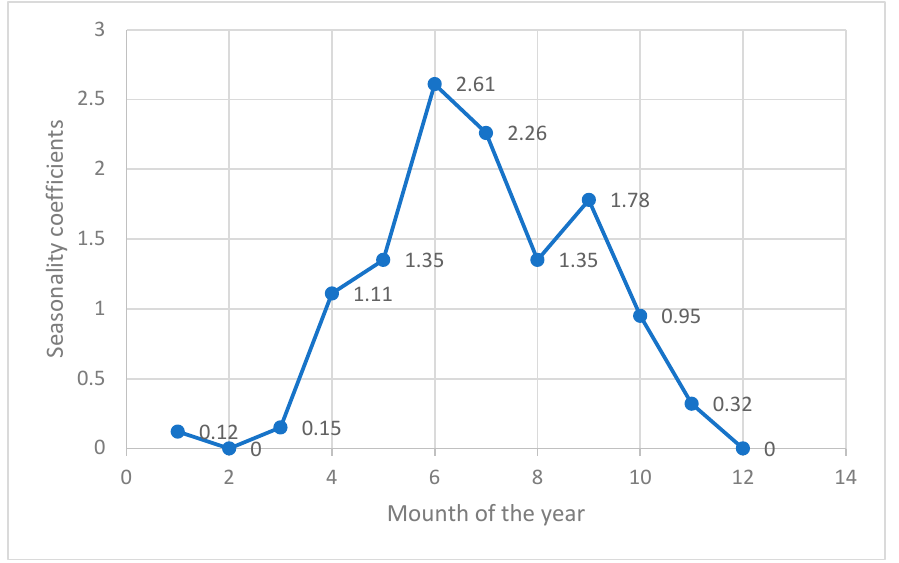
8 of 22 Table 3. Results of expert forecasting in pcs. Calculation of the Function y = bx + a B